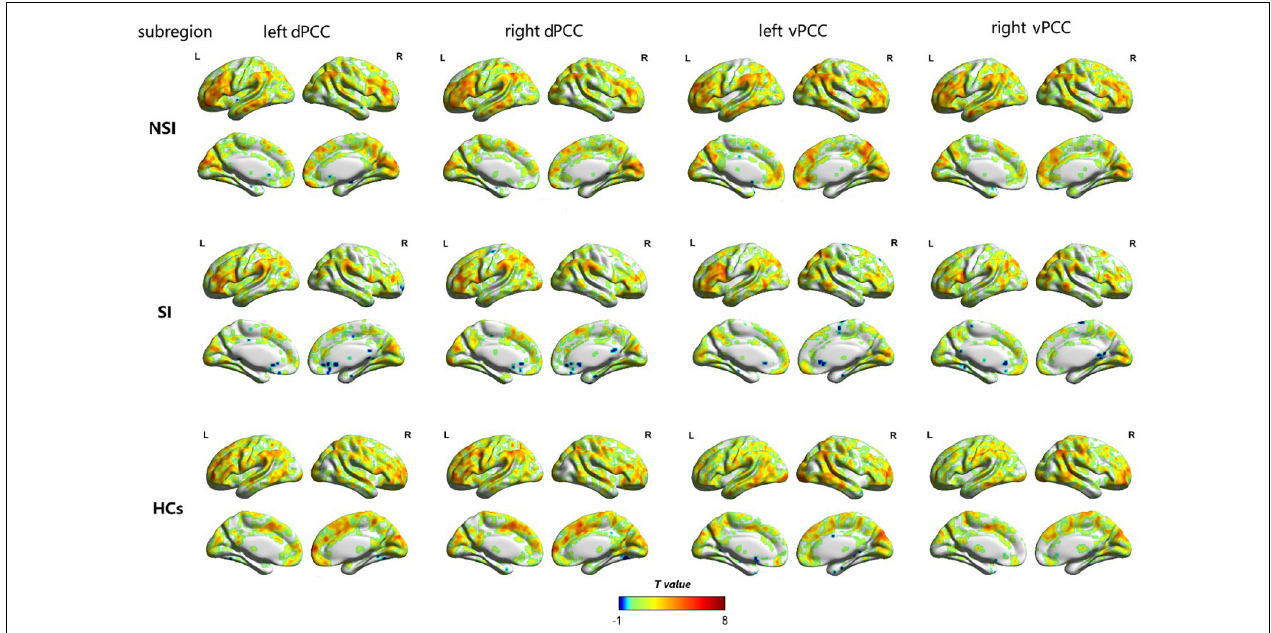
FIGURE 2 | The dFC variability patterns of the bilateral dorsal posterior cingulate cortex (dPCC) and the bilateral ventral posterior cingulate cortex (vPCC) within NSI, SI and HCs groups ( p < 0.05, uncorrected). The color bar represents a dynamic functional connection. dFC, dynamic functional connectivity; dPCC, dorsal posterior cingulate cortex; vPCC, ventral posterior cingulate cortex; SI, major depressive patients with suicidal ideation; NSI, major depressive patients without suicidal ideation; HCs, healthy controls.